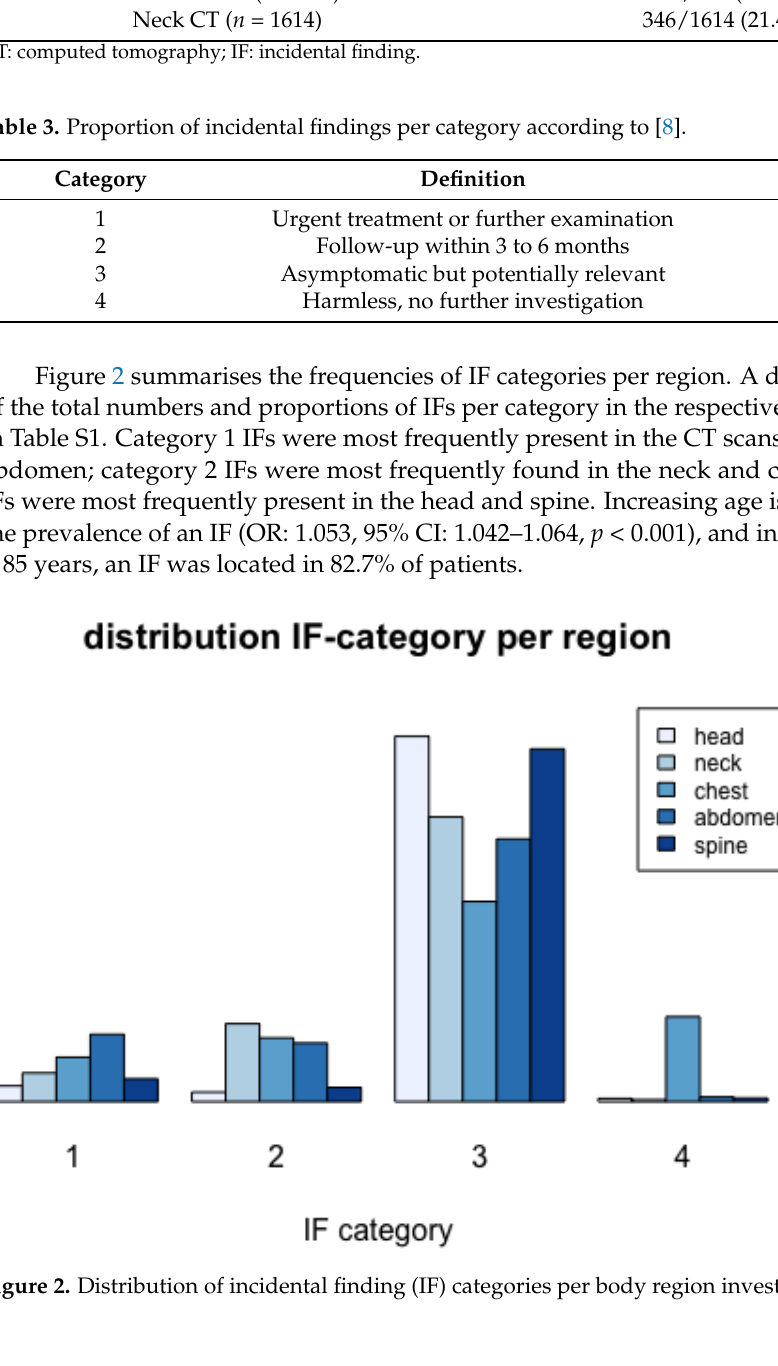
Figure 3. Distribution of incidental finding (IF) categories per age group.